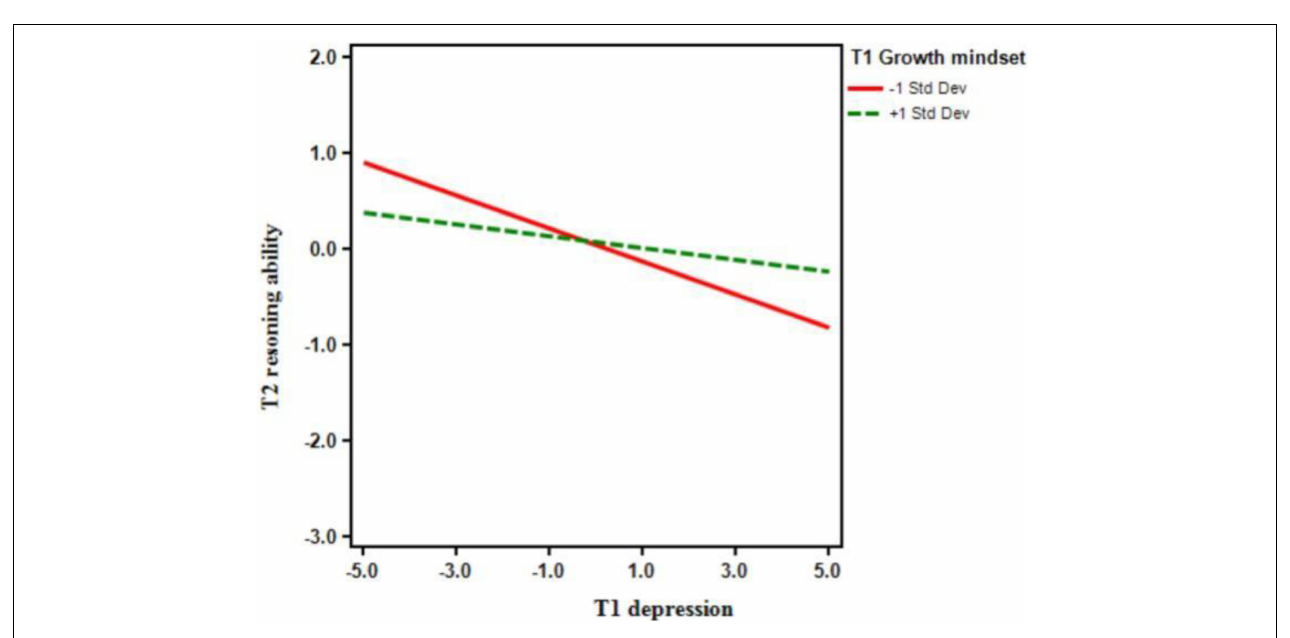
FIGURE 4 | The moderation effect of T1 growth mindset on the relationship between T1 depression and T1 reasoning ability in adolescents.